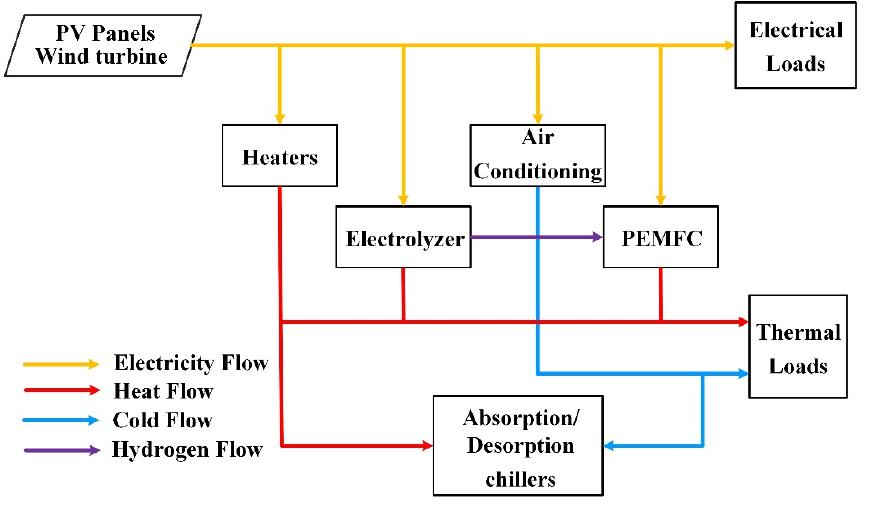
Figure 13. Working principle of tri-generation.